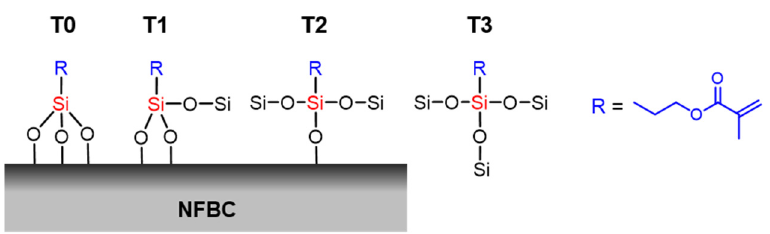
Figure 13. Schematic showing monomeric (T0), singly (T1), doubly (T2), and fully (T3) condensed silicon atoms on the NFBC surface.